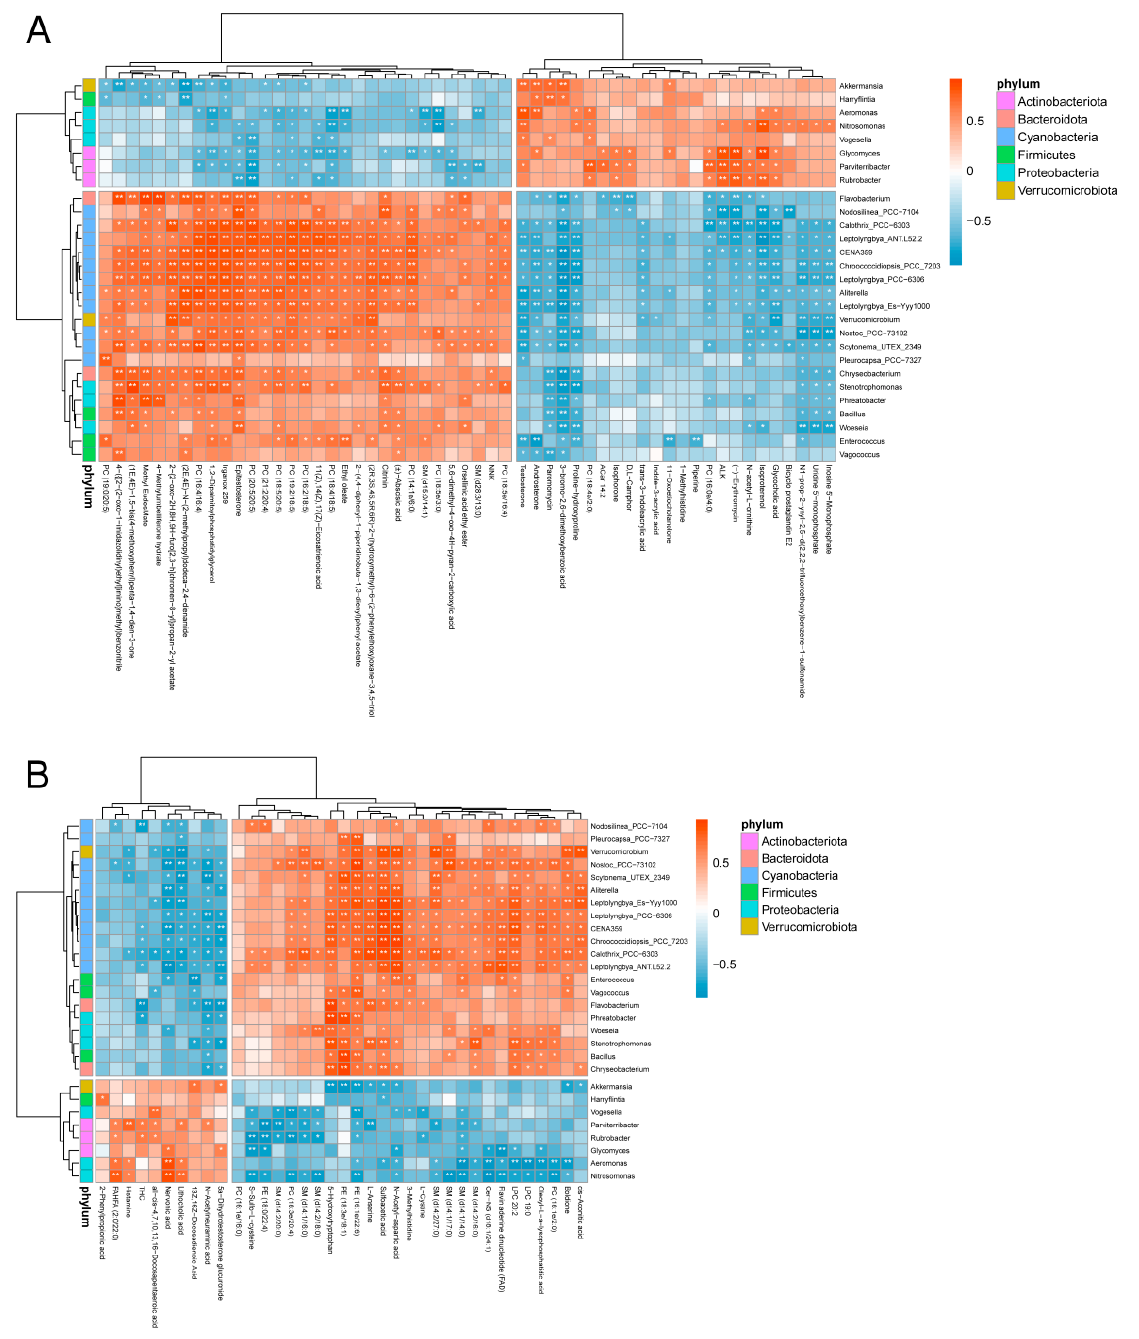
Figure 5. Integrated correlation analysis of sex-biased microbes and metabolites in adult Chinese alligators. Heatmap of Spearman’s rank correlation coefficients of metabolites from positive ( A ) and negative ( B ) ion modes. The shade of color indicates the magnitude of the correlation coefficient (red and blue indicate positive and negative correlations, respectively). Significant correlations are indicated by white stars: * p < 0.05, ** p < 0.01.